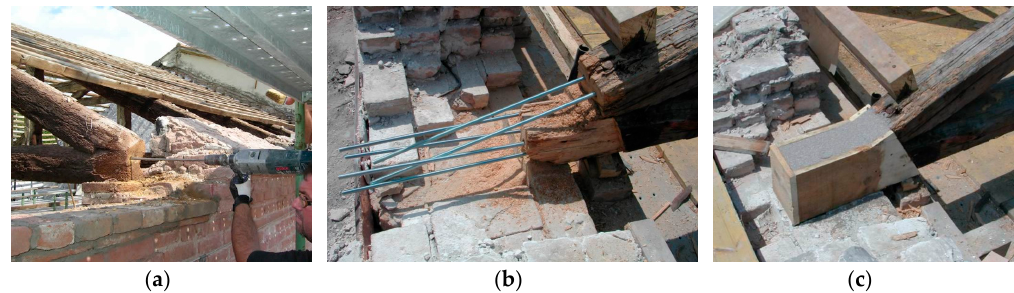
Figure 15. Re-construction of tie or rafter ends with stainless steel rods [45]: ( a ) drilling the holes for rod installation; ( b ) insertion of the stainless steel rods; ( c ) resin casting.